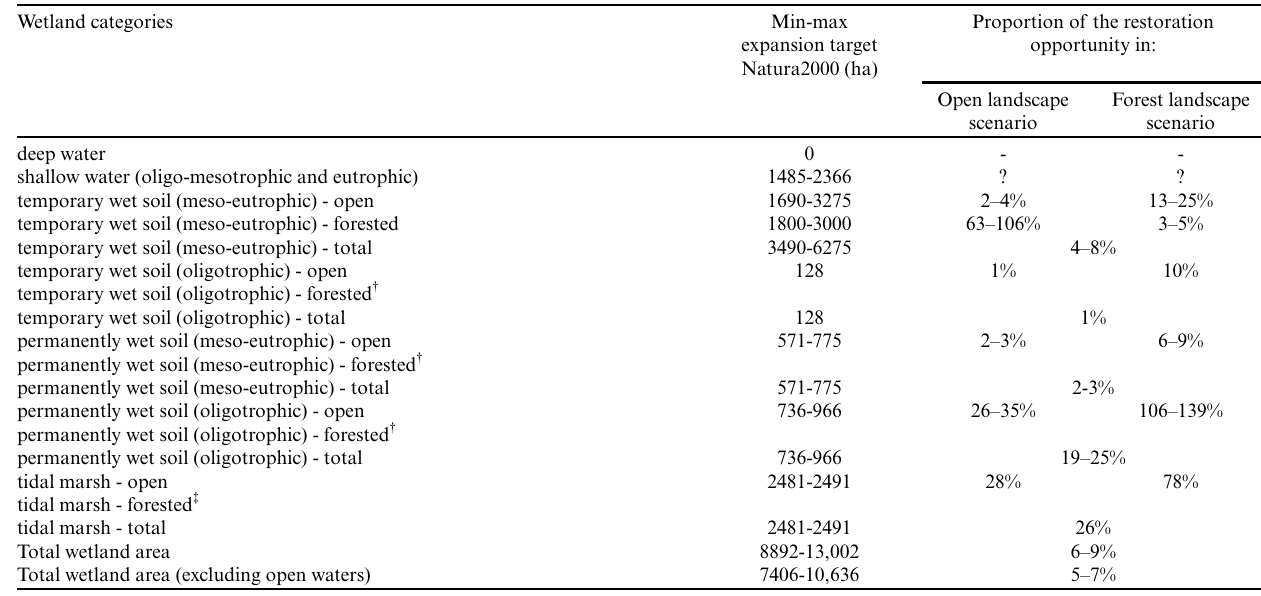
Table 5. Ambition level for the expansion of wetland habitats within the Flemish Natura 2000 policy framework in perspective with the available restoration opportunities (defined as potential area for wetland restoration in the two scenarios, reduced with already existing wetland area). † All increase of alluvial forests (habitat type 91E0) was assigned to meso-eutrophic wetlands on temporary wet soil. ‡ No distinction could be made between forested and nonforested tidal